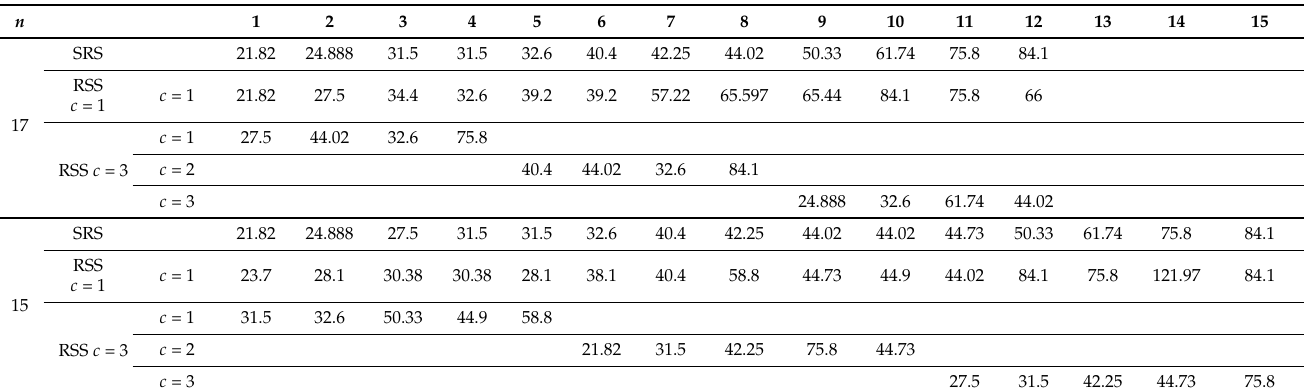
Table 11. SRS and RSS for the flood data.